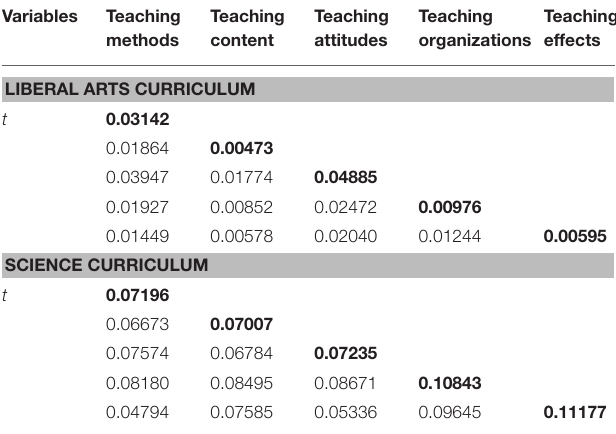
TABLE 8 | Variance components and covariance components from G study, effect of curriculum